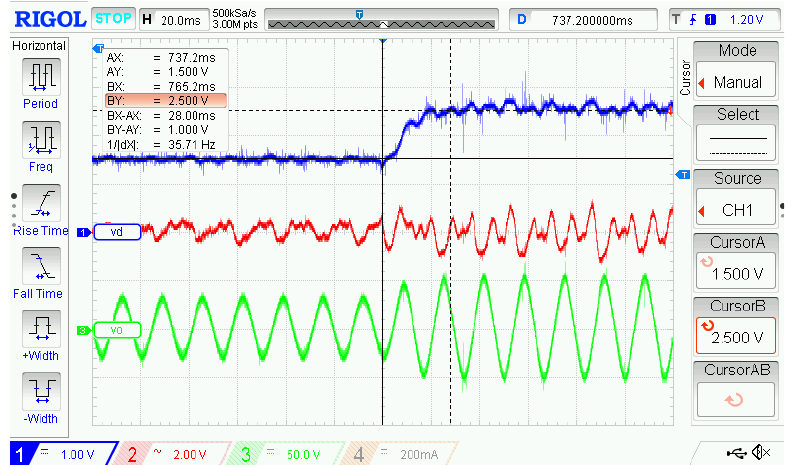
Figure 23. Measurement of output voltage and dq axis voltages as the reference is